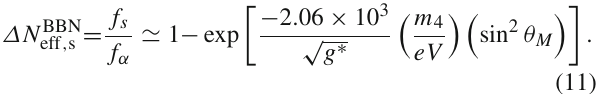
Fig. 1 Theblueandmagentaregionscorrespondtotheallowedregions in m χ − g s plane from (cid:12) N eff (taking contribution form sterile neutrino only) constraints of BBN ( (cid:12) N eff (cid:2) 0 . 5) for θ 0 = 0 . 1 and 0 . 05; grey region above g s = 10 − 4 is disfavored by SNe energy loss bounds, whereas the grey region to the right of m χ = 0 . 1 eV is disfavored from CMB, LSS bound on Σ m